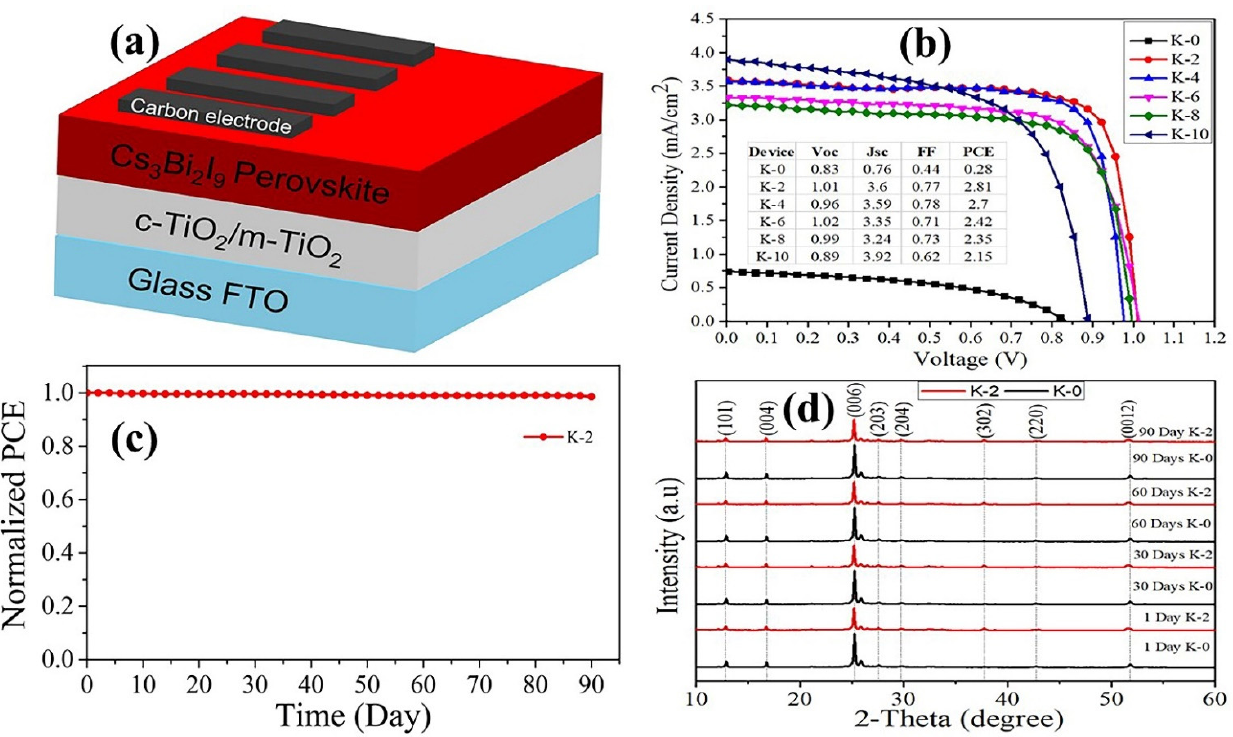
Figure 9. ( a ) Schematics of device architecture; ( b ) J-V curves and inserted device parameters for K-0, K-2, K-4, K-6, K-8, and K-10; ( c ) normalized PCE for K-2 device storage-time stability in ambient air from 0 to 90 days; ( d ) XRD characterization patterns from 1 to 90 days for K-0 and K-2 devices.